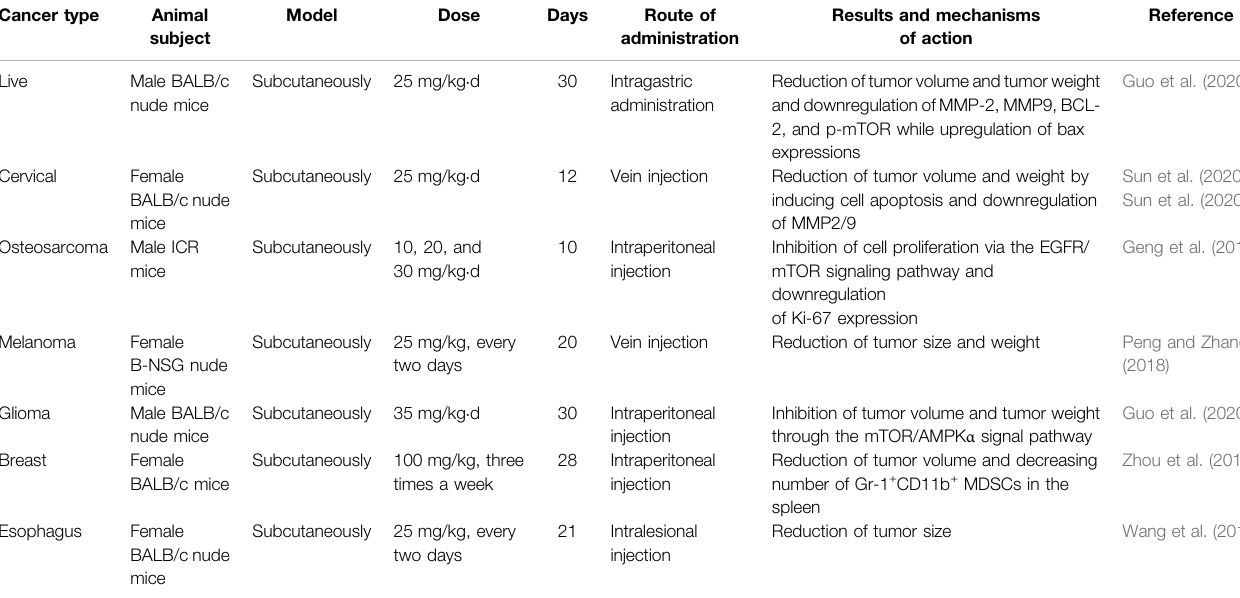
TABLE 3 | Therapeutic potential of Icariside II in vivo .